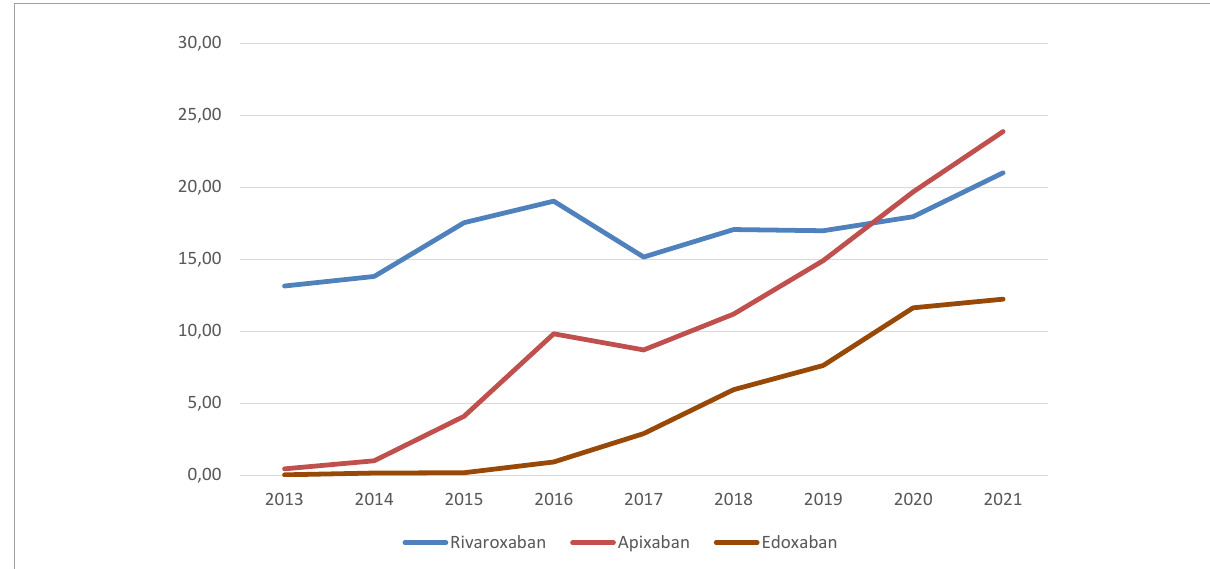
FIGURE1 Cumulative rates of patients receiving DOACs for initial and/or long-term therapy of VTE over